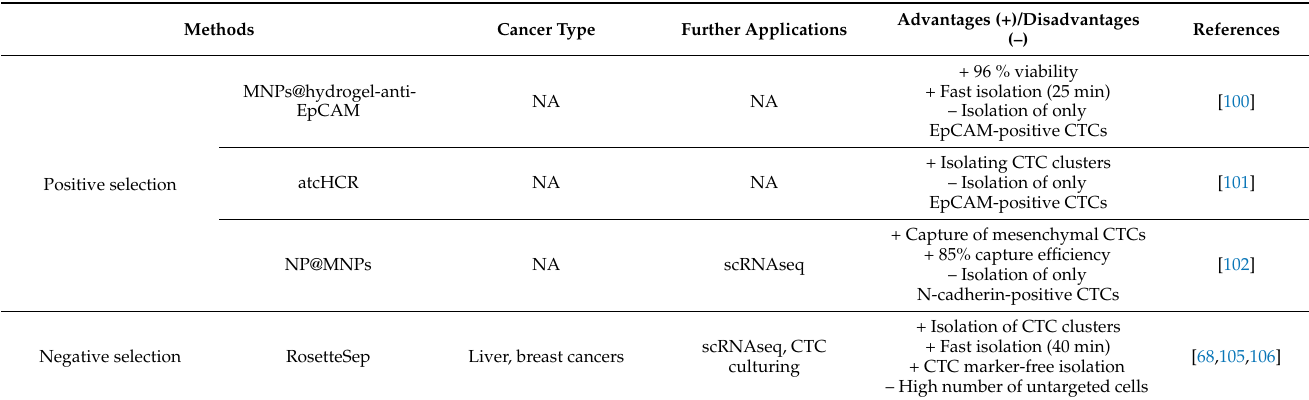
Table 2. Methods for isolating viable CTCs based on cell biological properties.